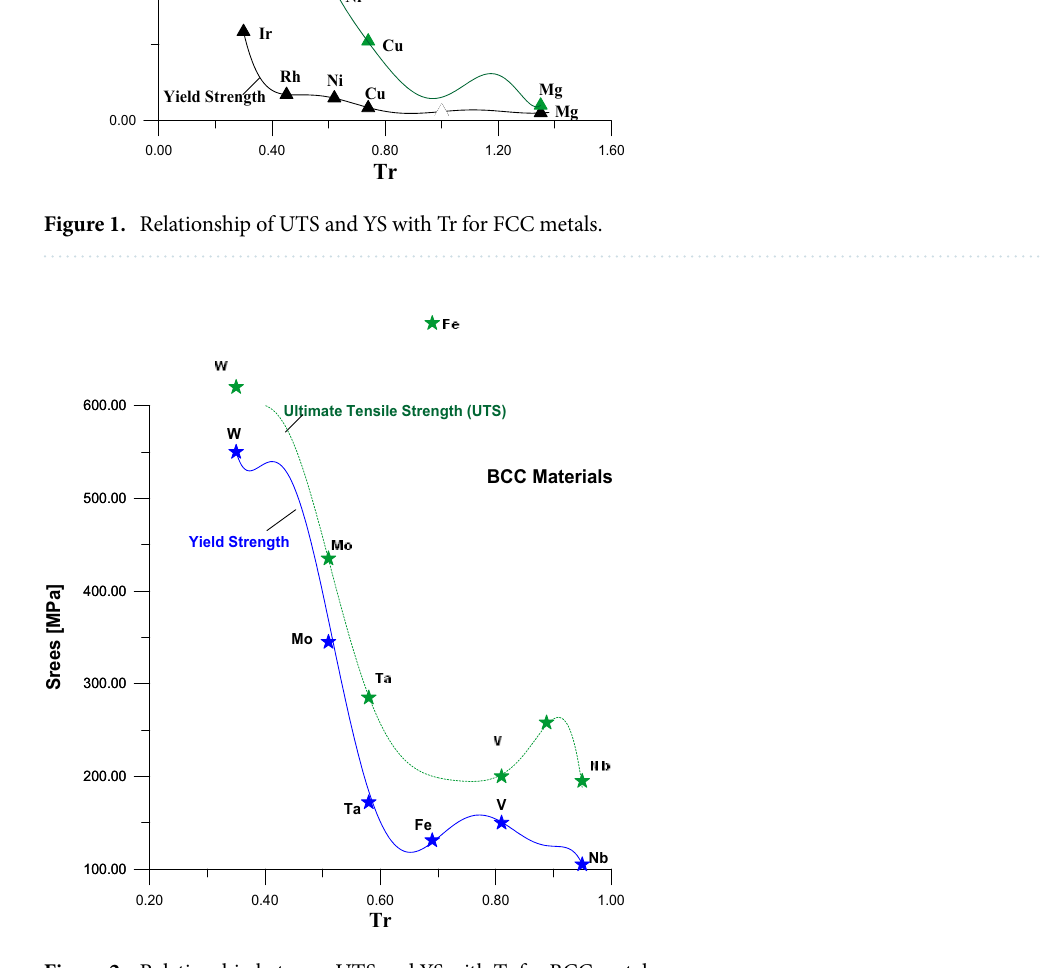
Figure 2. Relationship between UTS and YS with Tr for BCC